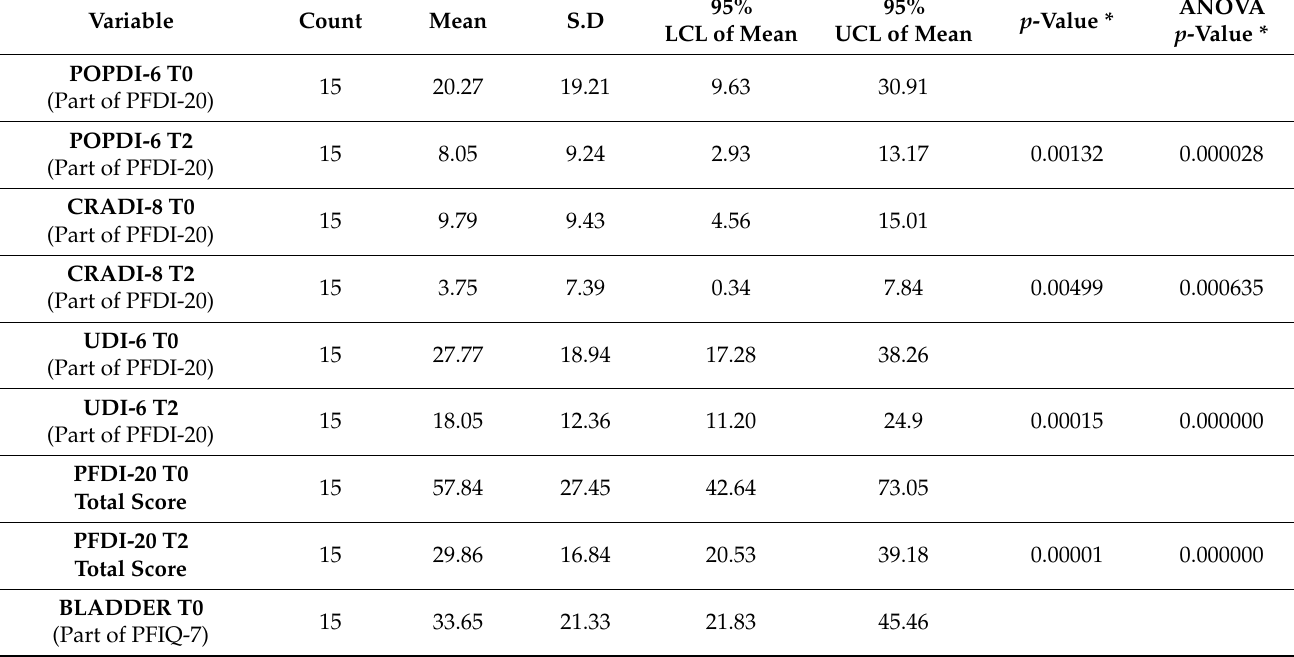
Table 2. Outcome measures statistical analysis in PFDI-20 and PFIQ-7